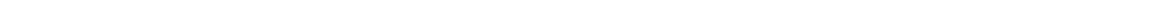
Fig. 5 NAc D 1 R neurons sparsely target NAc-projecting VTA DA neurons. a Schematic of the experimental protocol. Cre-dependent ChR2 was injected